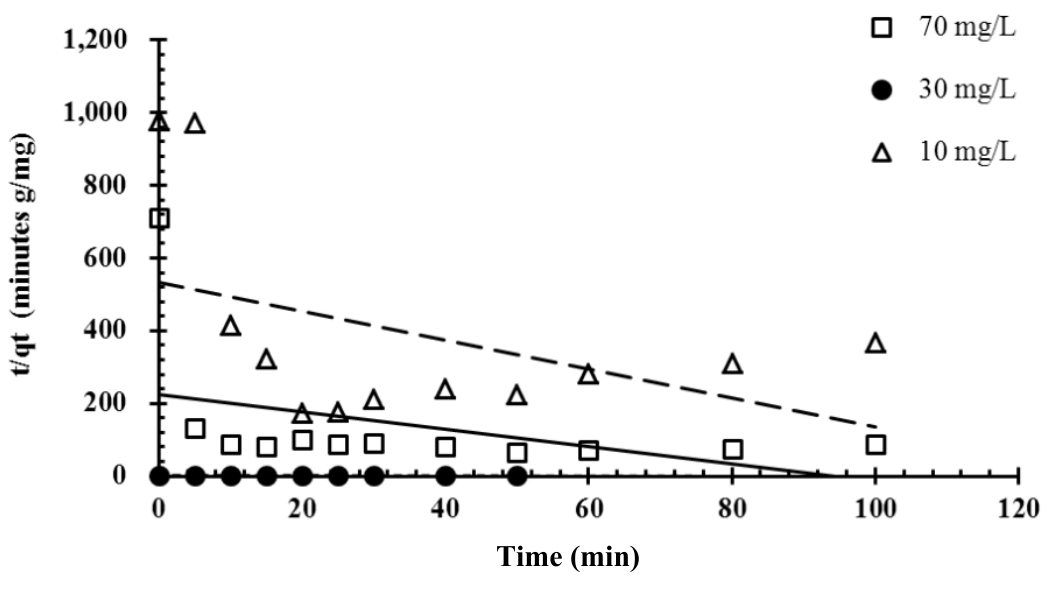
Figure 7. Linearized pseudo-second-order kinetics plot of the biosorption of malachite green onto immobilized cells of P. sanguineus at various concentrations of composite